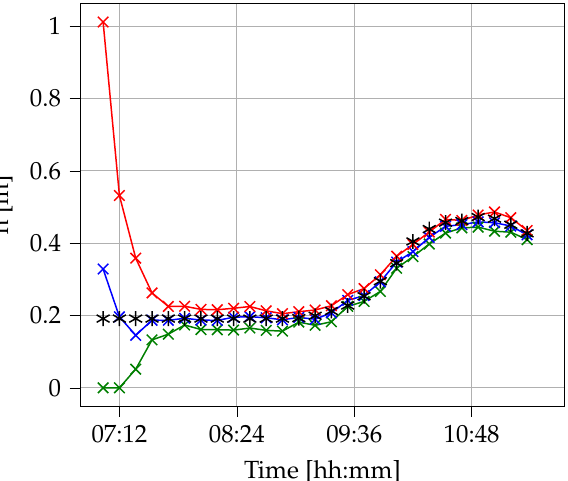
Figure 10. Measured water level (black) and minimal (green), mean (blue), maximal (red) estimated water levels at sensor location